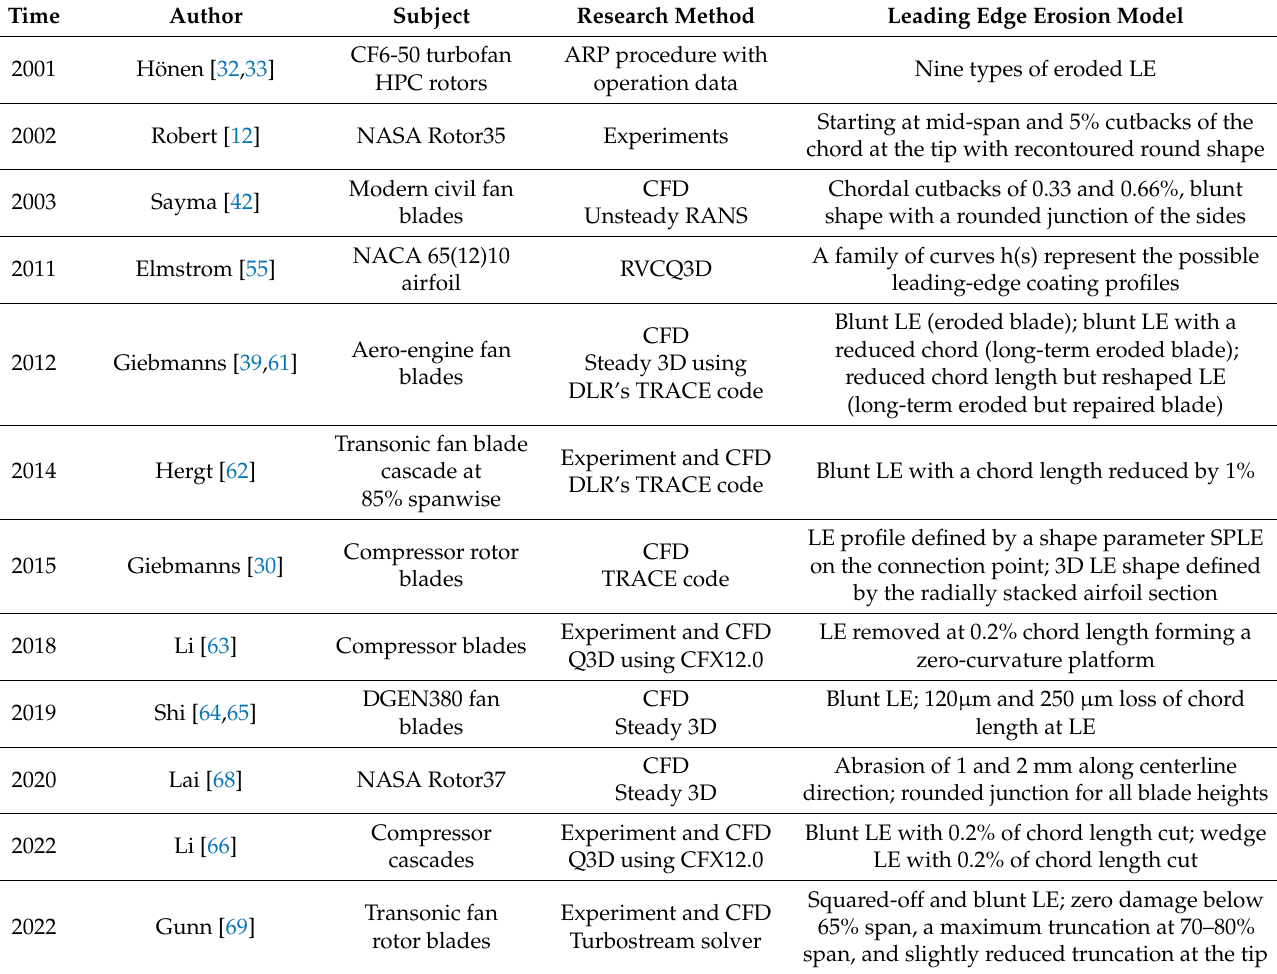
Table 1. Leading edge erosion models established in the past 20 years.